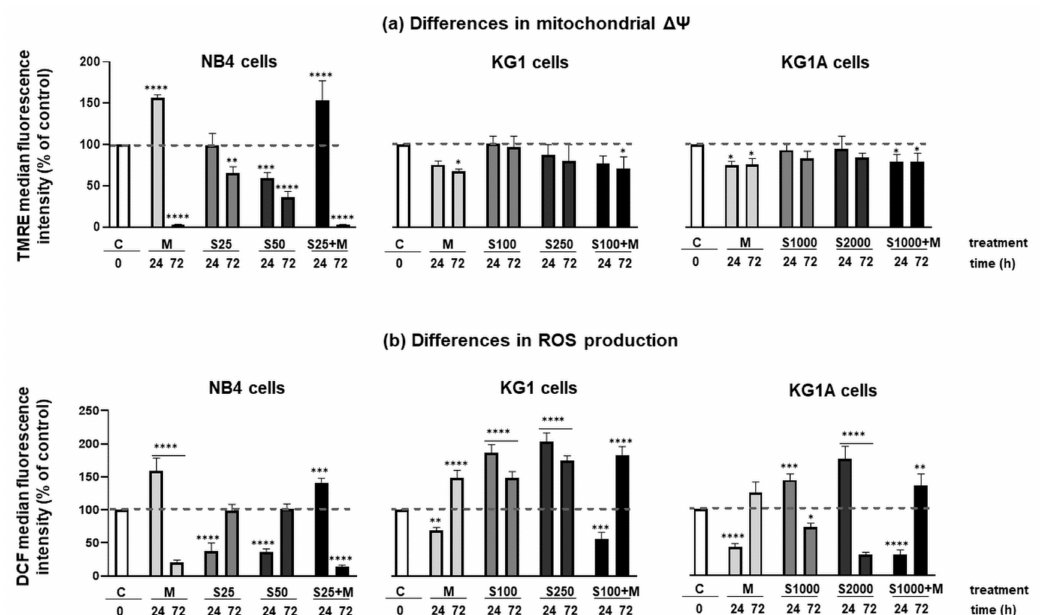
Figure 3. Effect of metformin and MCL-1 inhibitor S63845 on myeloid leukemia cell mitochondrial membrane potential and cellular reactive oxygen species production. For subsequent flow cytometric analysis NB4 cells were treated with 25 nM and 50 nM S63845, 10 mM metformin and combination of 25 nM S63845 + 10 mM metformin. KG1 cells were treated with 100 nM and 250 nM S63845, 10 mM metformin and combination of 100 nM S63845 + 10 mM metformin. KG1A cells were treated with 1000 nM and 2000 nM S63845, 10 mM metformin and combination of 1000 nM S63845 + 10 mM metformin. ( a ) Mitochondrial membrane potential ( ∆ ψ m) of control (untreated) and treated NB4, KG1 and KG1A cells was evaluated using TMRE Mitochondrial membrane potential assay kit (ab113852) after 24 and 72 h of incubation. ( b ) Measurements of ROS production in control (untreated) and treated NB4, KG1 and KG1A cells were performed using Abcam DCFDA Cellular ROS detection assay kit (ab113851) after 24 and 72 h of incubation. Note: * denotes significant difference between treated vs. control cells with p < 0.05, ** denotes significant difference with p < 0.01, *** denotes significant difference with p < 0.005 and **** denotes significant difference with p < 0.0001, as evaluated using 1-way ANOVA with Dunnett post hoc